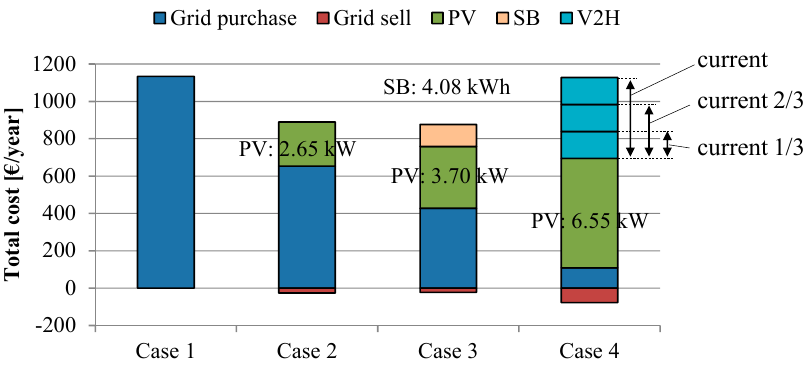
Figure 8. Cost structure and the optimum sizes of PV and stationary battery (SB) of the minimum cost solution for the cases of non-commuter EV.